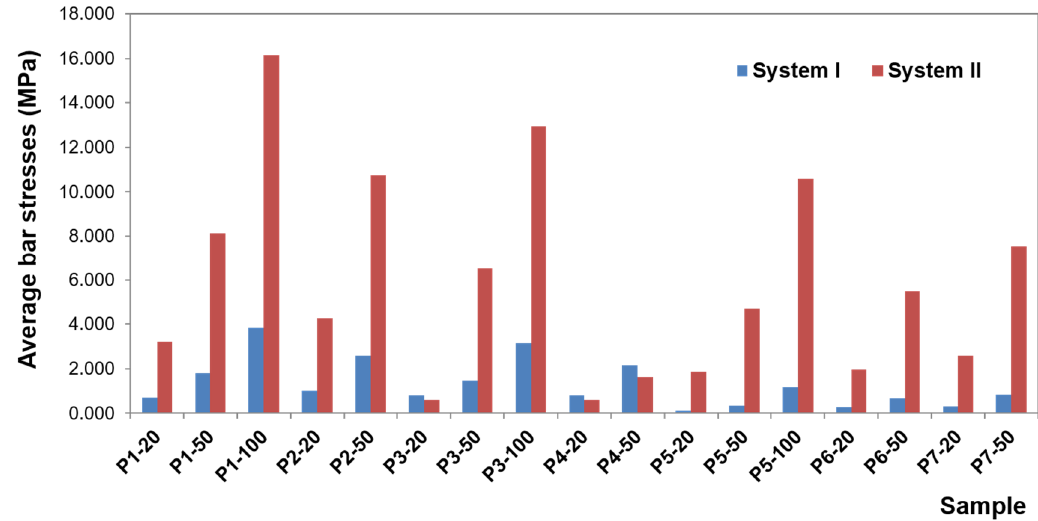
Figure 11. Average bar stresses in the first and second system.